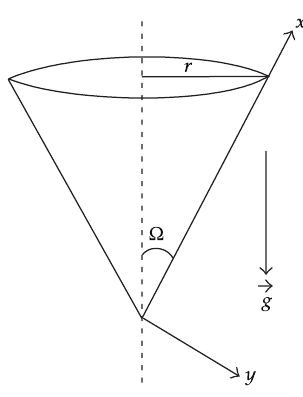
Figure 1: Schematic of the